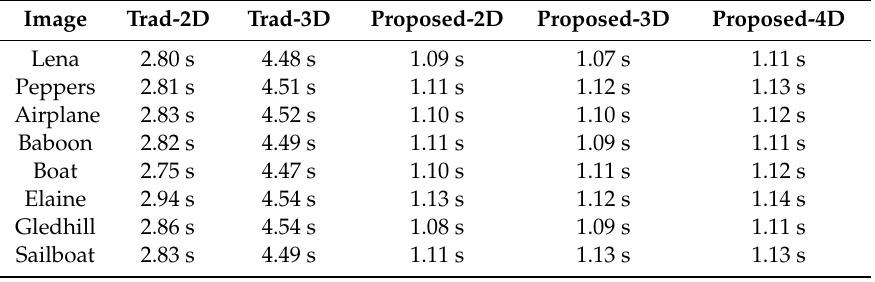
Table 7. Comparison of time e ffi ciency between the proposed scheme and traditional algorithm.